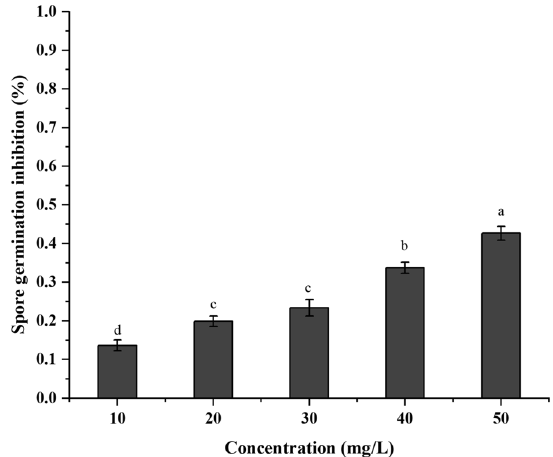
Fig. 2 Inhibition effects of different concentrations of surfactin on spore germination of B. cinerea . The error bars represent the SEs of the three replicates